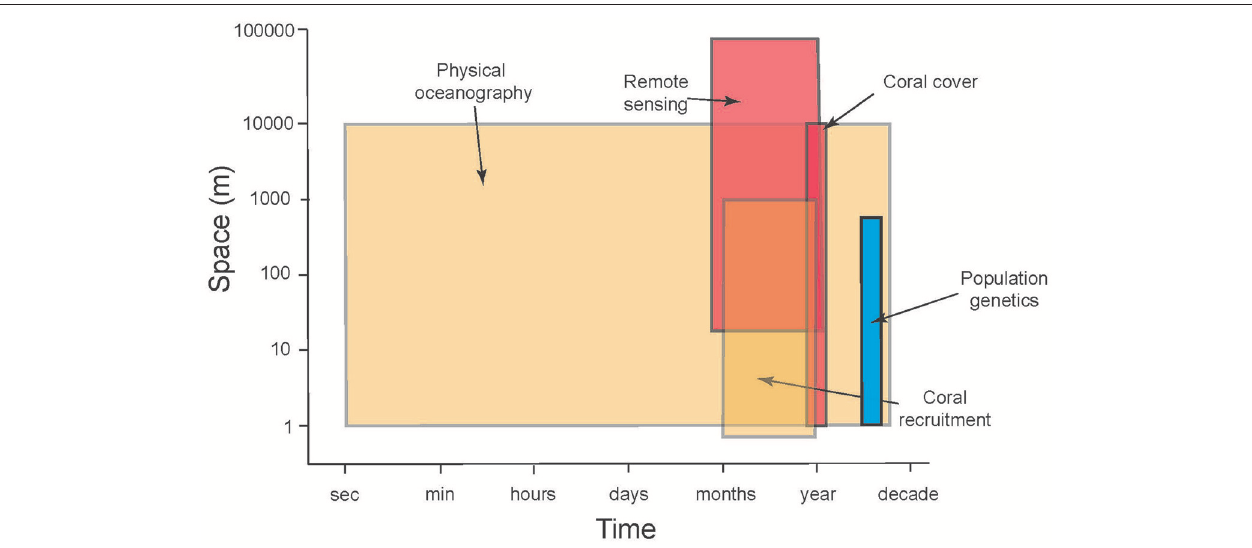
FIGURE 2 | Schematic illustrating the mismatch between scales of space (ordinate) and time (frequency of sampling, abscissa) in time-series analyses of CRI that are relevant to evaluating the roles of connectivity to reef resilience following disturbance. Shading indicates approximate longevity (number of years that sampling